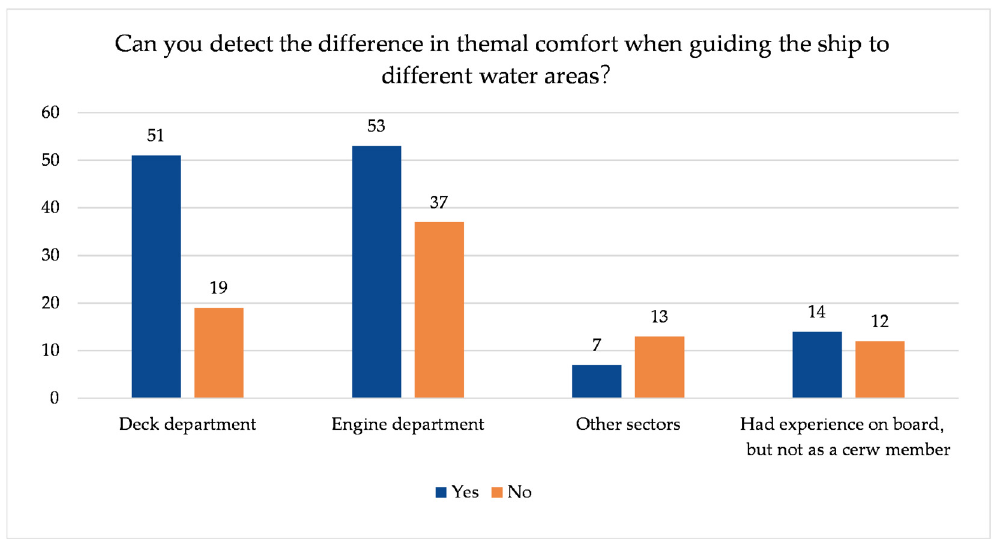
Figure 10. Questionnaire for departments and thermal sensitivity.